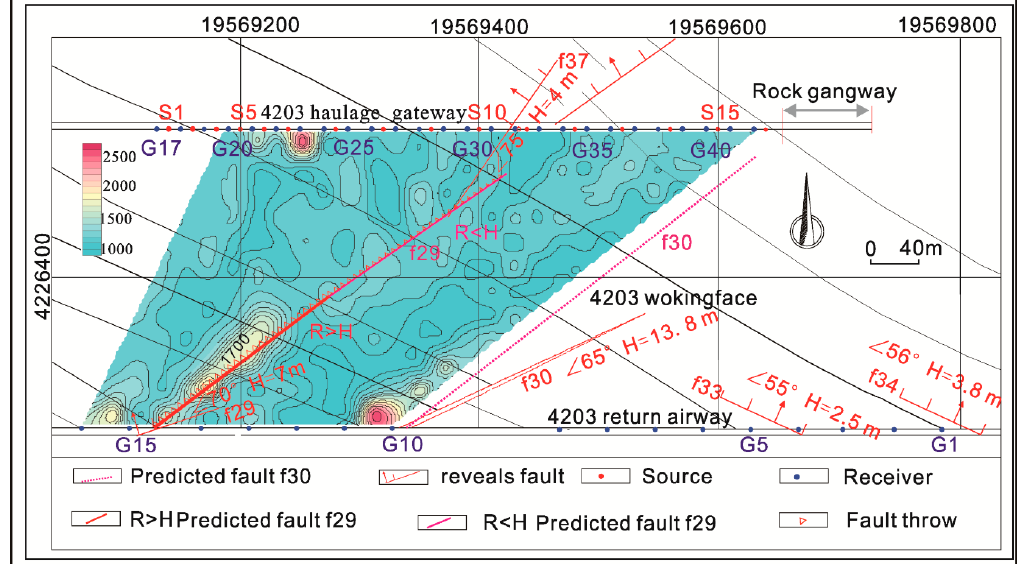
Figure 11. Results for the transmission and reflection of the channel wave for the 4203 working